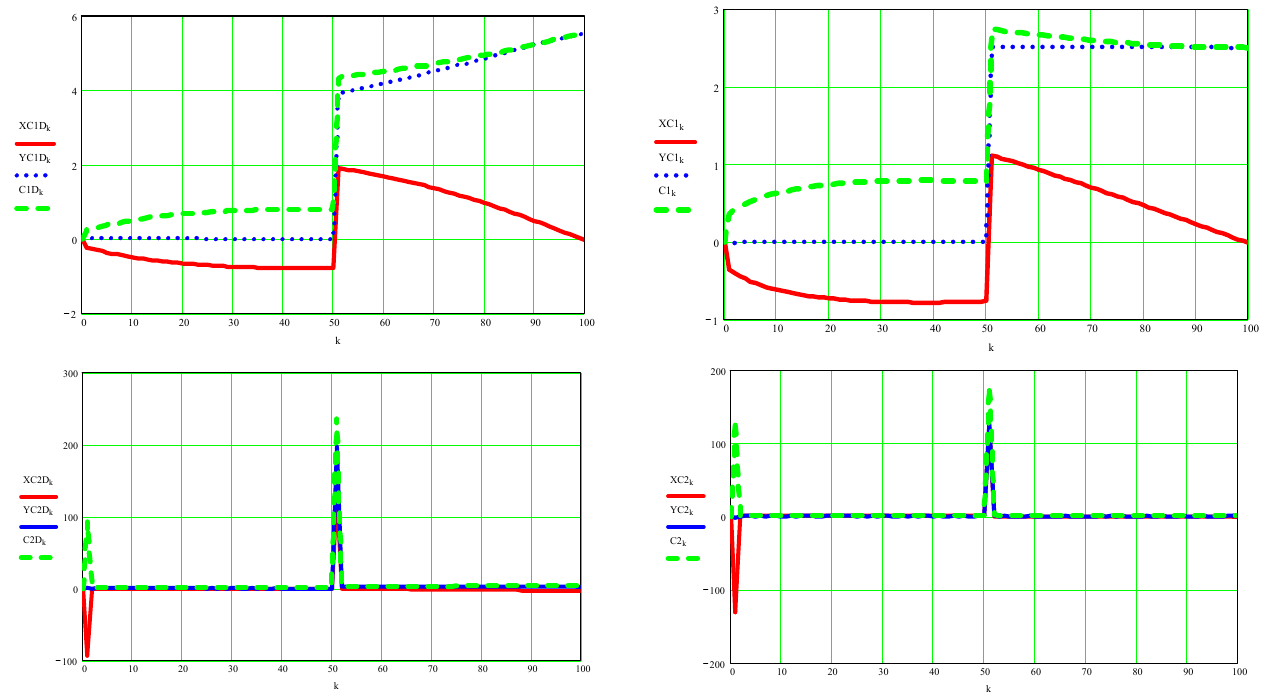
Figure A11. Here are represented the velocities of point B in their scalar coordinates (with red for the x-axis and with blue for the y-axis) and in absolute value (with green), dynamic on the left and kinematic on the right, at the top, and below are similarly represented the accelerations corresponding to the same point B.